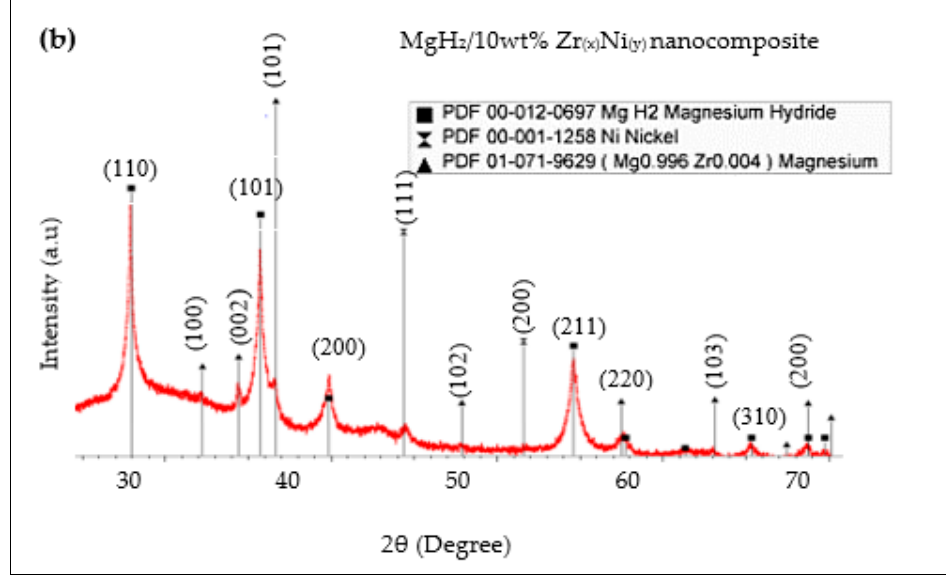
Figure 5. The XRD patterns of ( a ) 10 wt.% Zr (x) Ni (y) nanocomposite in red and the un-milled MgH 2 used as reference in black and ( b ) MgH 2 /10 wt.% Zr (x) Ni (y) nanocomposite to identify the crystal phase of each element.